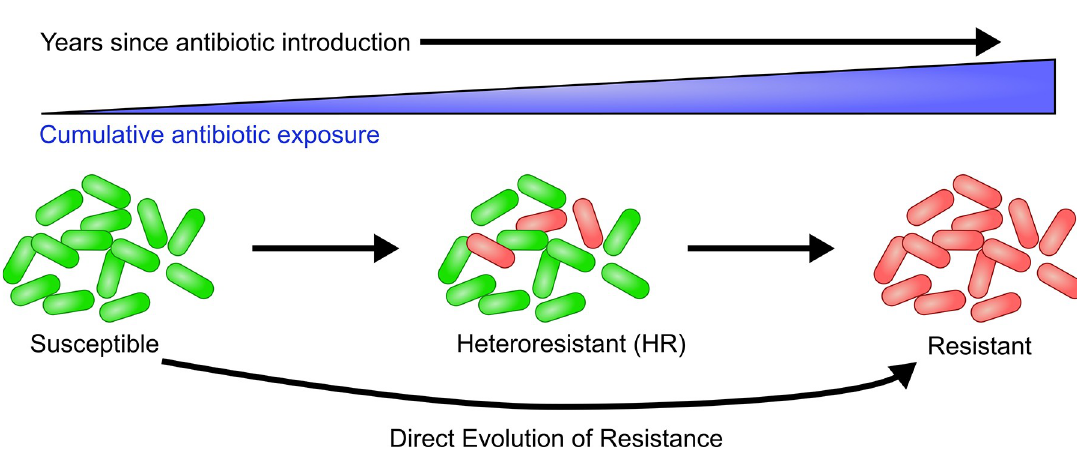
Fig 3. Proposed model for the evolution of resistance through heteroresistance. With increasing years after the introduction of an antibiotic, bacterial strains are cumulatively exposed to an increasing amount of the antibiotic. Strains are initially susceptible (green cells), but antibiotic exposure leads to the development of a resistant subpopulation (red cells). Increased antibiotic exposure eventually leads to resistance. Direct evolution of resistant isolates from susceptible isolates is also indicated. HR, heteroresistant.